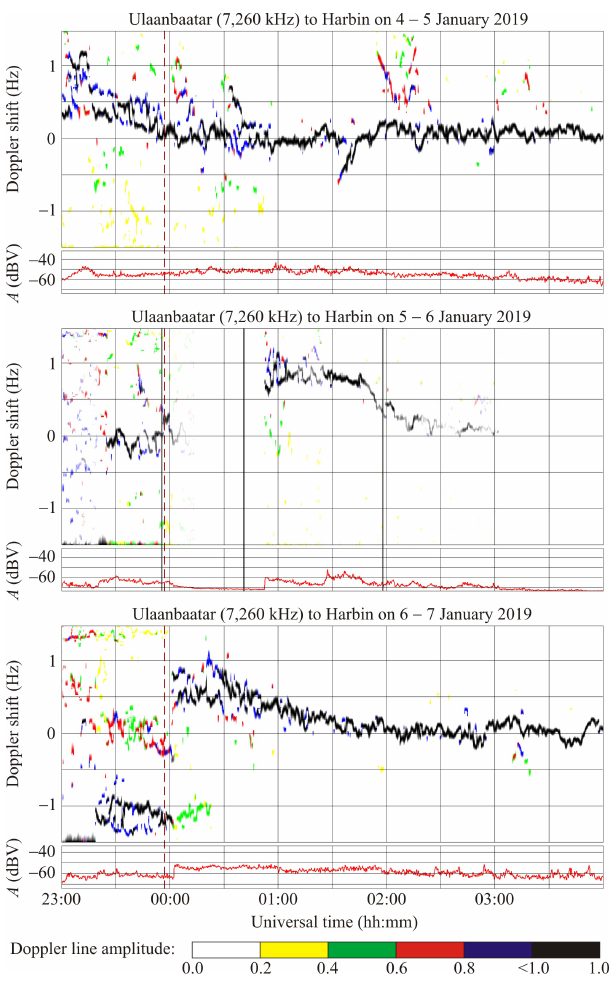
Figure 7. The same as in Fig. 4 but for the Shijiazhuang to Harbin radio-wave propagation